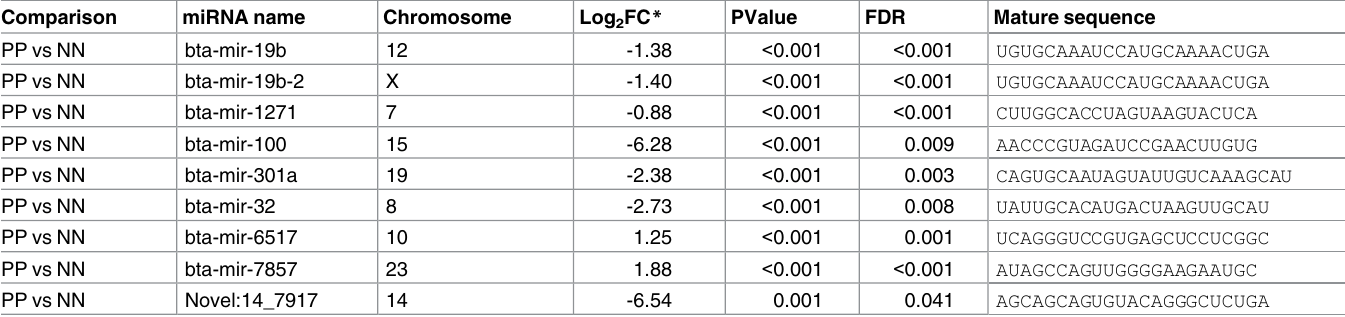
Table 1. Differentially expressed miRNAs in PP vs NN